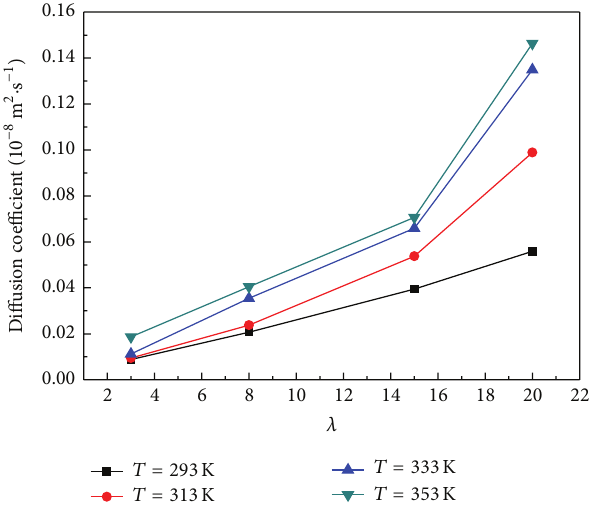
Figure 7: The variations in the diffusion coefficient of the hydrated ion with water content at different cell